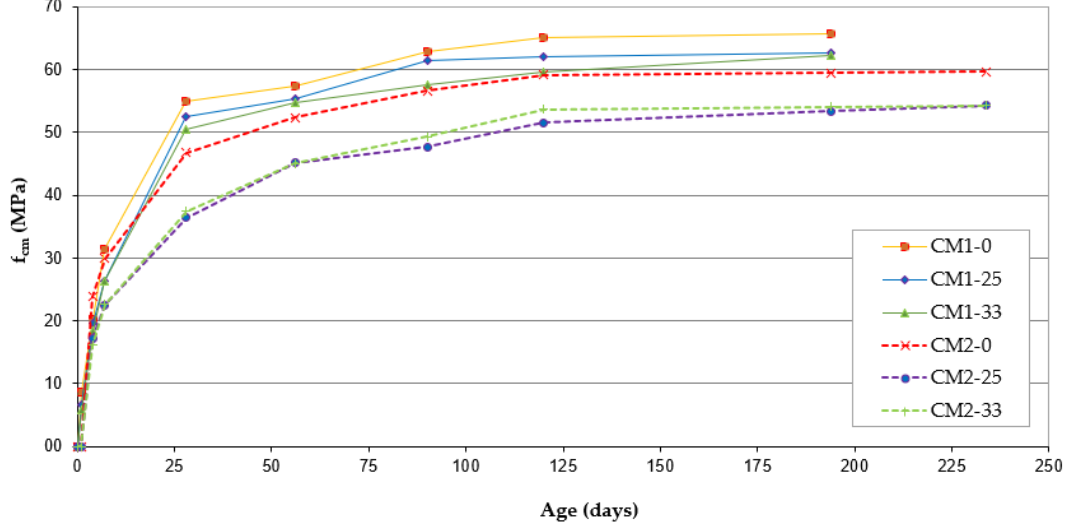
Figure 4. Compressive strength means values of concretes as a function of maturation time.